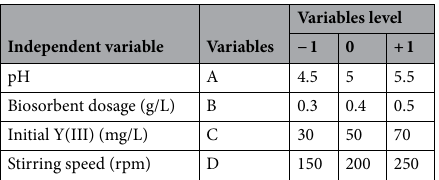
Table 1. Design of the coding limits and levels of independent